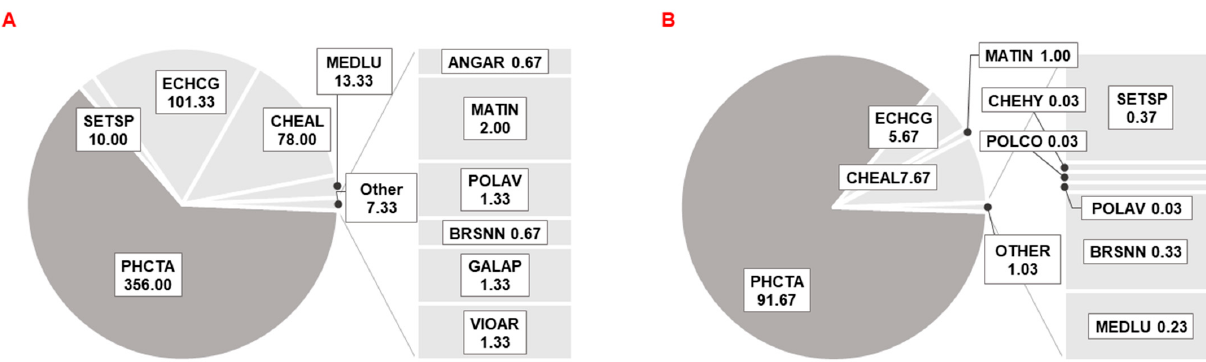
Figure A2. Number of plants per m 2 —Sowing 2 (24th of April) in 2018 ( A ) and leaf coverage in %— Sowing 2 (24th of April) in 2018 ( B ). Figure A3. Number of plants per m 2 —Sowing 3 (10th of May) in 2018 ( A ) and leaf coverage in %— Sowing 3 (10th of May) in 2018 ( B ).